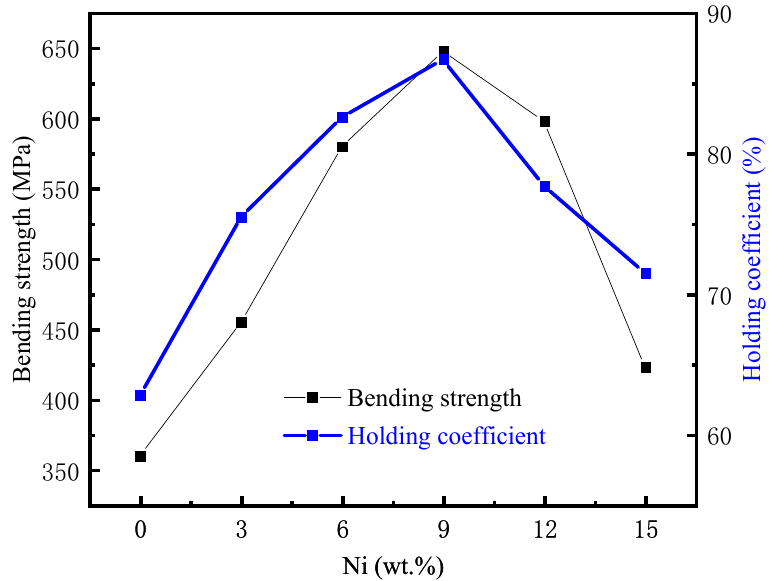
Figure 8. The effect of Ni content on the bending strength of diamond tools and holding coefficient of the sintered matrix on diamond.